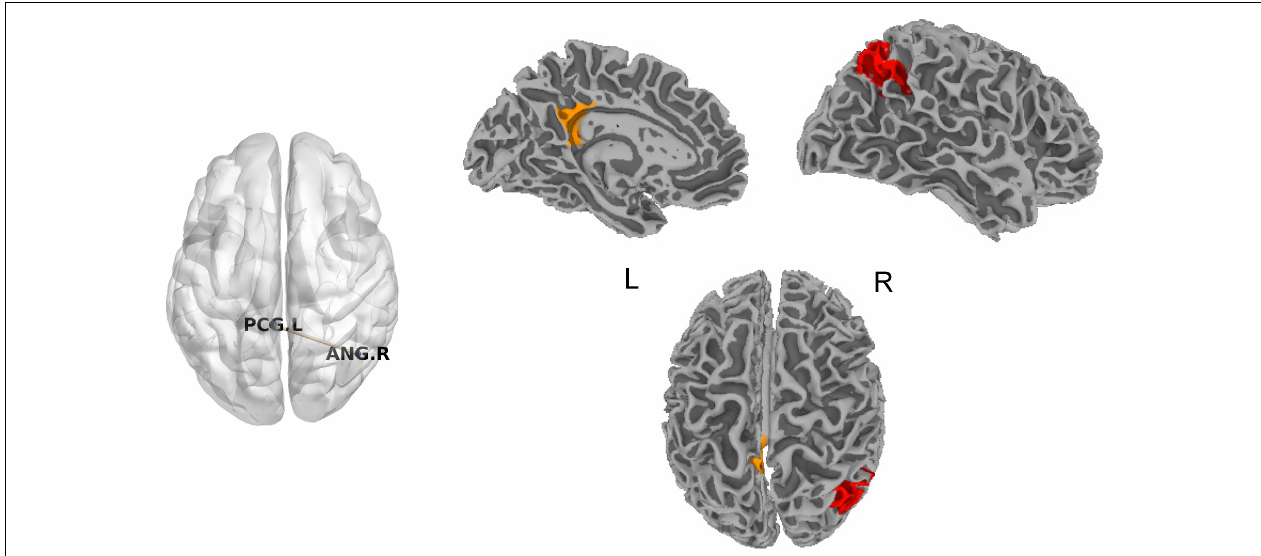
FIGURE 1 | Significant difference for SFC in chronic tinnitus patients before and after acupuncture. ANG, angular gyrus; L, left; PCG, posterior cingulate gyrus; R, right; SFC, static functional connectivity.